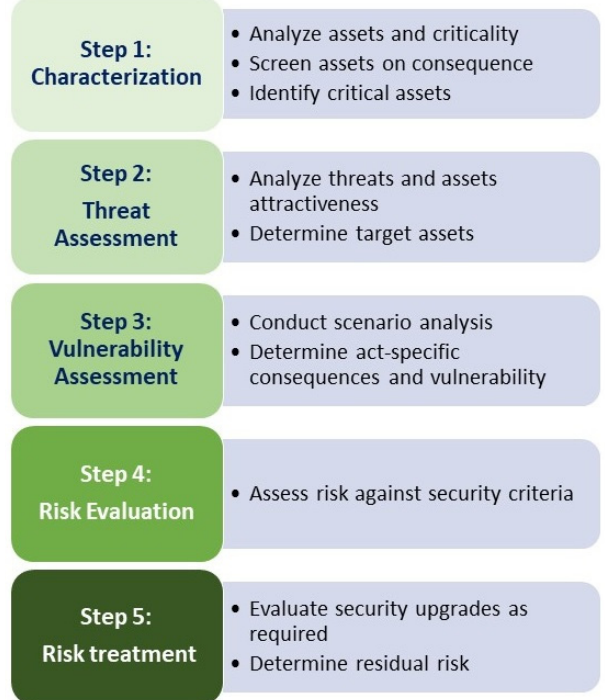
Figure 3. API SRA process (source: [76], with information elaborated by authors).